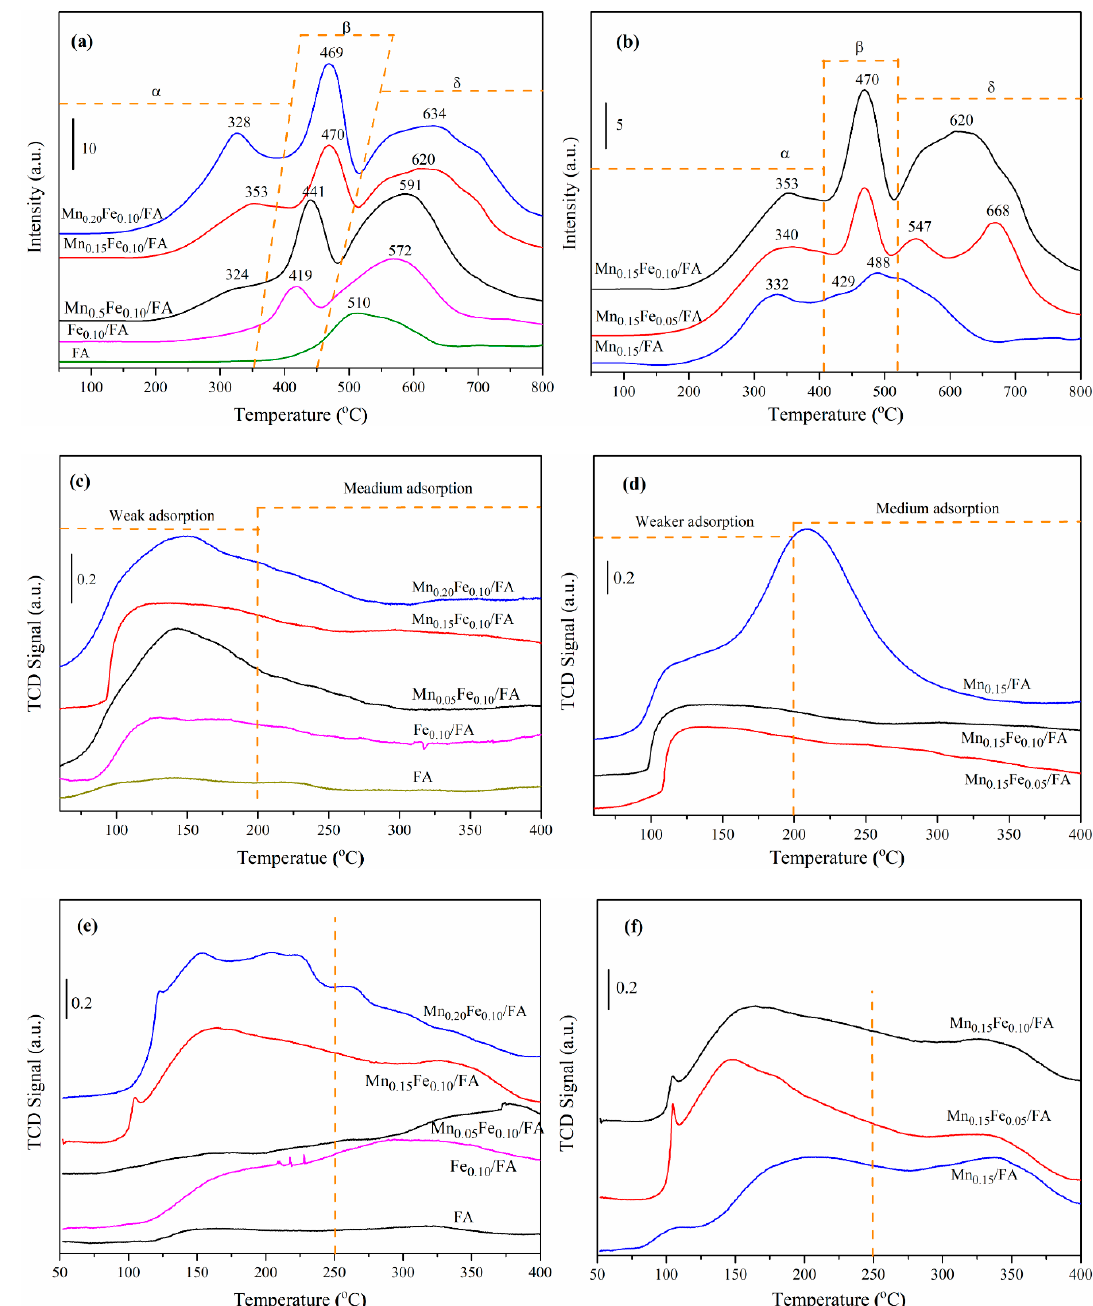
Figure 2. Profiles of H 2 -TPR ( a ), NH 3 -TPD ( c ), and NO-TPD ( e ) of Mn x Fe 0.10 /FA (x = 0, 0.05, 0.15 and 0.20); and H 2 -TPR ( b ), NH 3 -TPD ( d ), and NO-TPD profiles ( f ) of Mn 0.15 Fe y /FA (y = 0, 0.05 and 0.10).